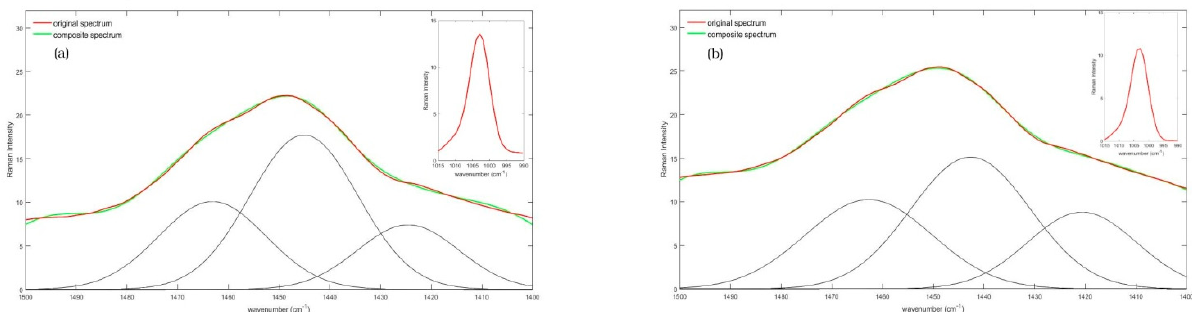
Figure 2. Average Raman spectrum, collected in the 1400–1500 cm − 1 spectral range of serum from ( a ) non-CD and; ( b ) CD subjects, with the deconvoluted curves. In both spectra, the red line represents the original mean Raman spectrum, the black line identifies the Gaussian deconvoluted curves, and the green line shows the resulting composite spectrum, obtained from deconvolution computation. In the top right box of both figures the reference Phe peak is also displayed.